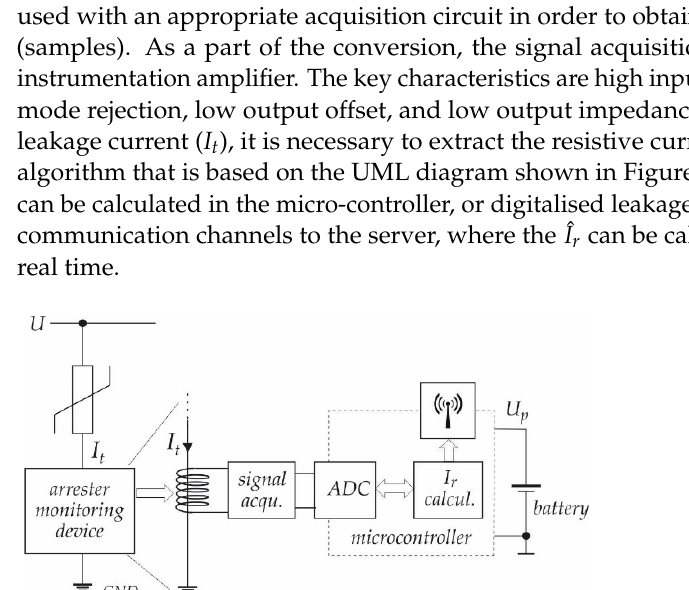
9 of 19 Table 4. Verification of measurement results. Measured Values